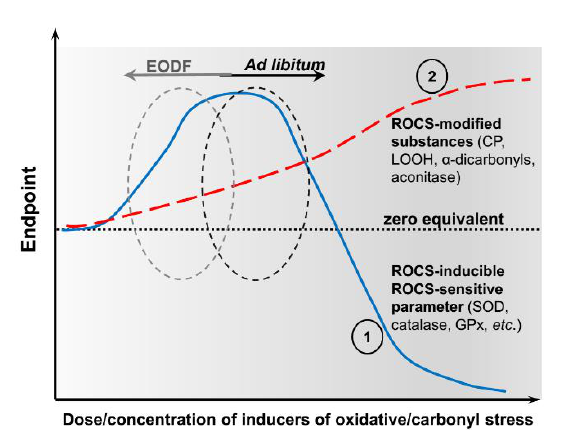
Figure 5: Schematic presentation of the results showing Endpoint responses of parameters of in- terest (ordinate) to varied dose/concentration of inducers of oxidative stress (abscissa). Line 1 (blue colored) shows dependence on the levels of ROCS-modified cellular component/s such as CP, LOOH, α-dicarbonyl compounds, and aconitase in this study, and line 2 (red colored) shows depend- ence on the levels of ROCS-activated and simul- taneously ROCS-sensitive components such as the activities of superoxide dismutase, catalase, and GPx in this study. Black and grey circles on curves 1 and 2 correspond to ad libitum and EODF fed animals,